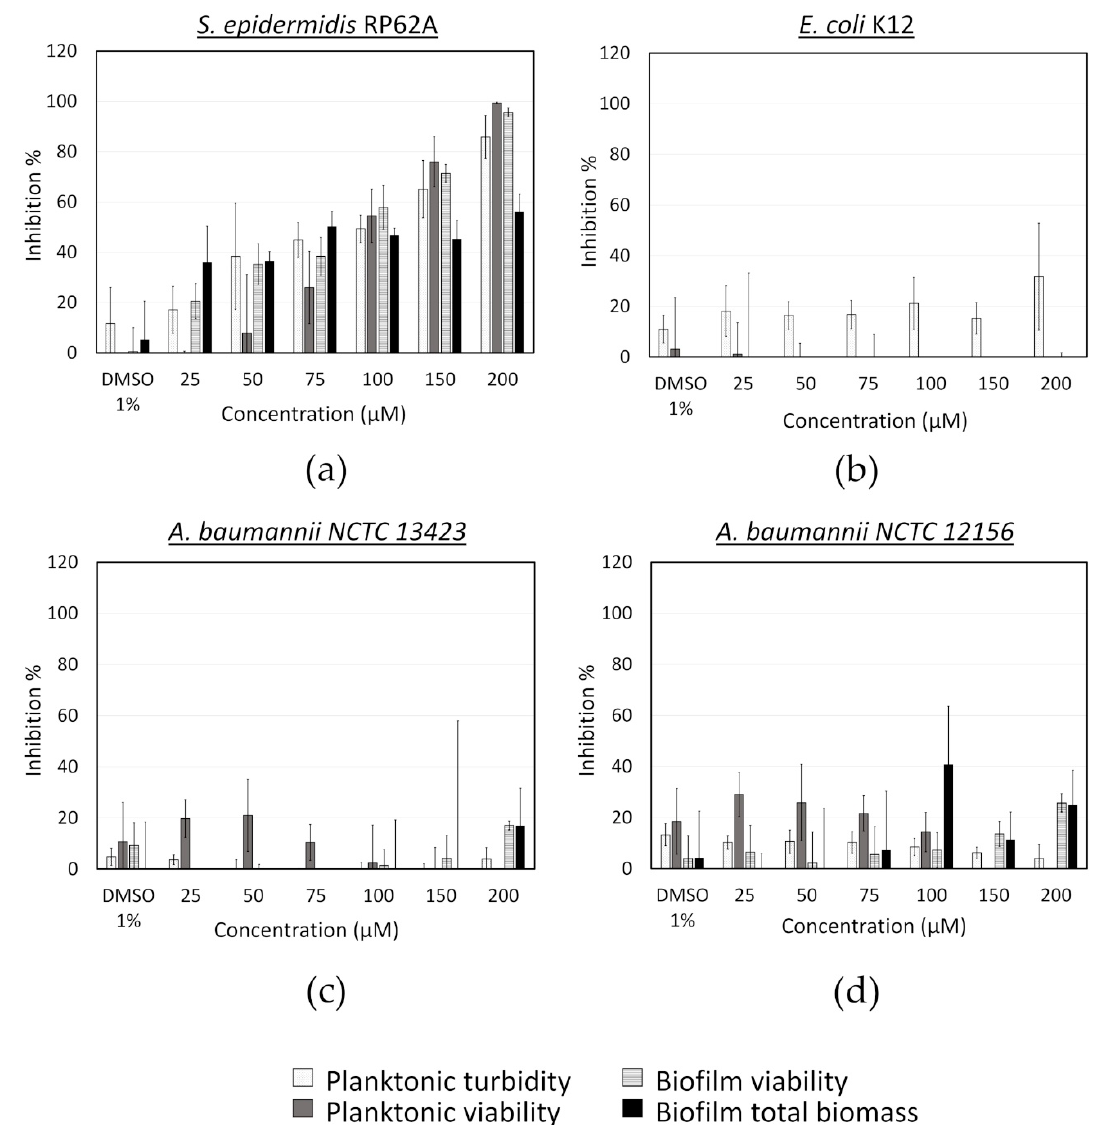
Figure A2. Activity of fingolimod against different bacterial species in the post-exposure mode. Results are from two distinct experiments with each two biofilm replicates for all concentrations ± SD.